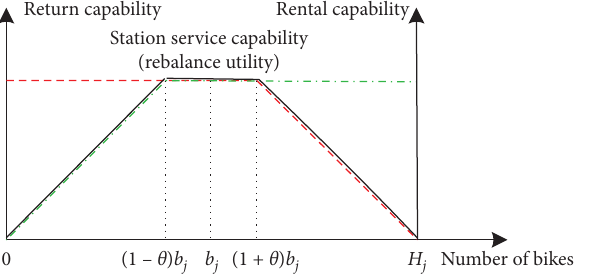
Figure 5: Station service capability. Green line represents the rental capability, red line represents the return capability, and black line represents the station service capability (rebalance